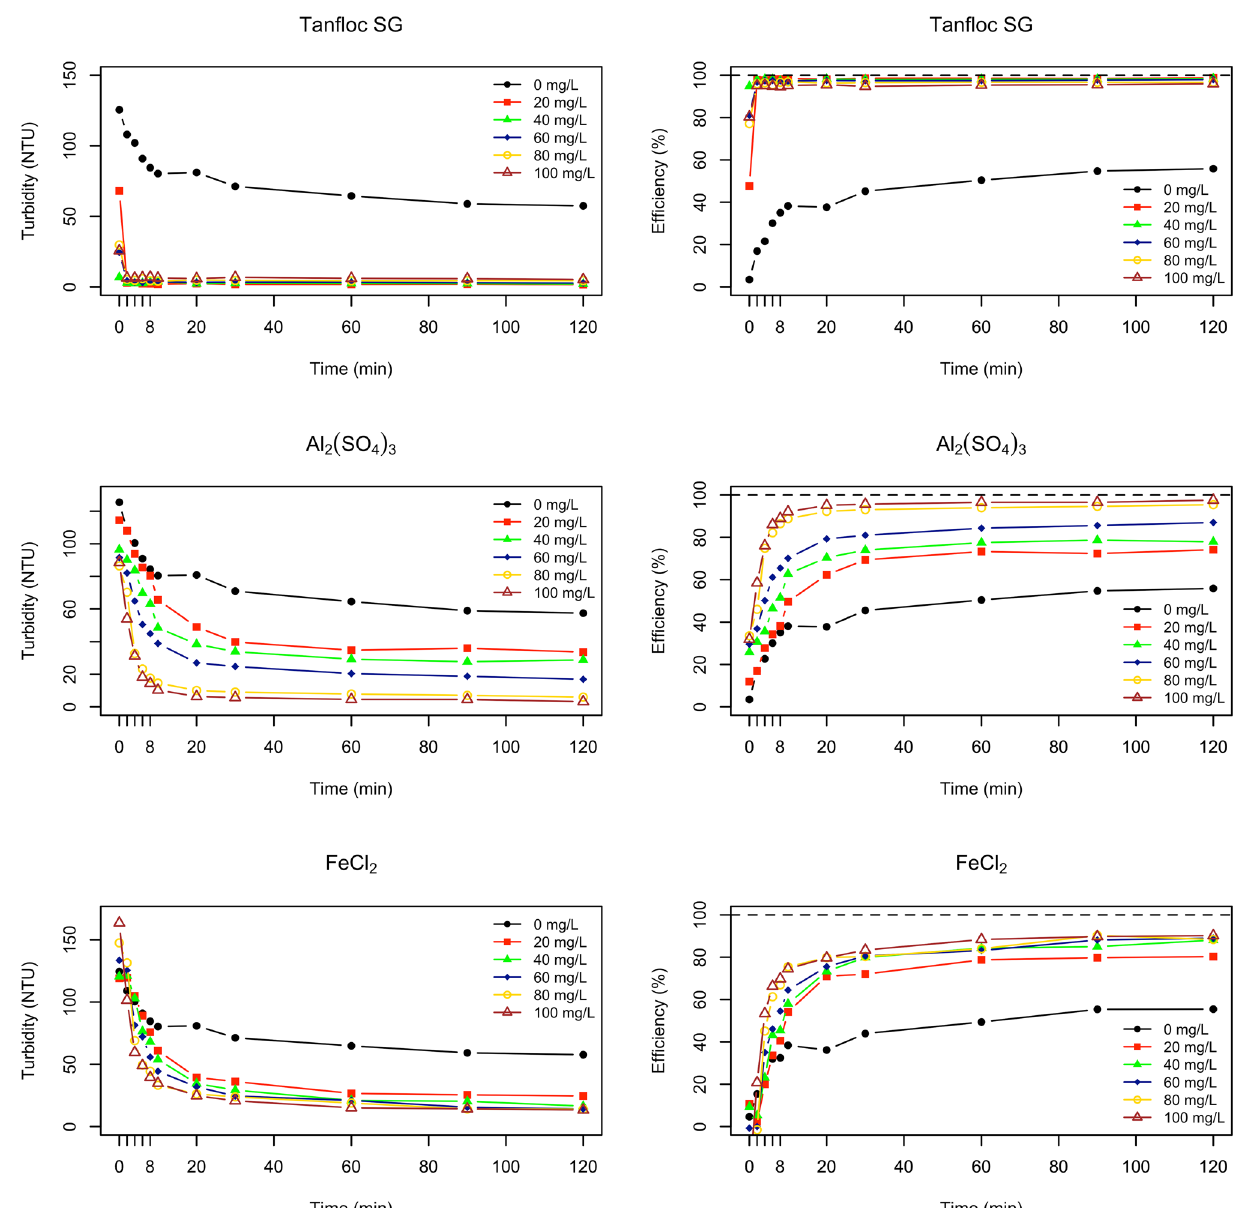
Fig. 1 Relationship of Turbidity and its removal efficiency as a function of time for Tanfloc SG®, Al